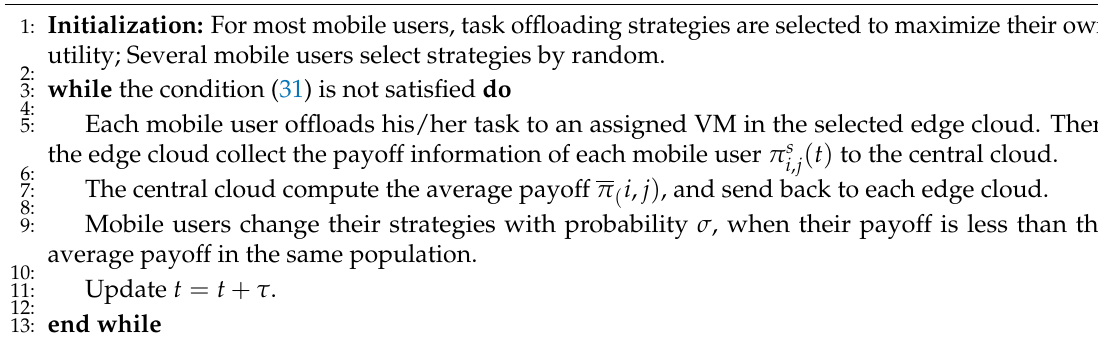
Algorithm 1 Iterative Algorithm on Cloud Selection and VM Configuration Assignment